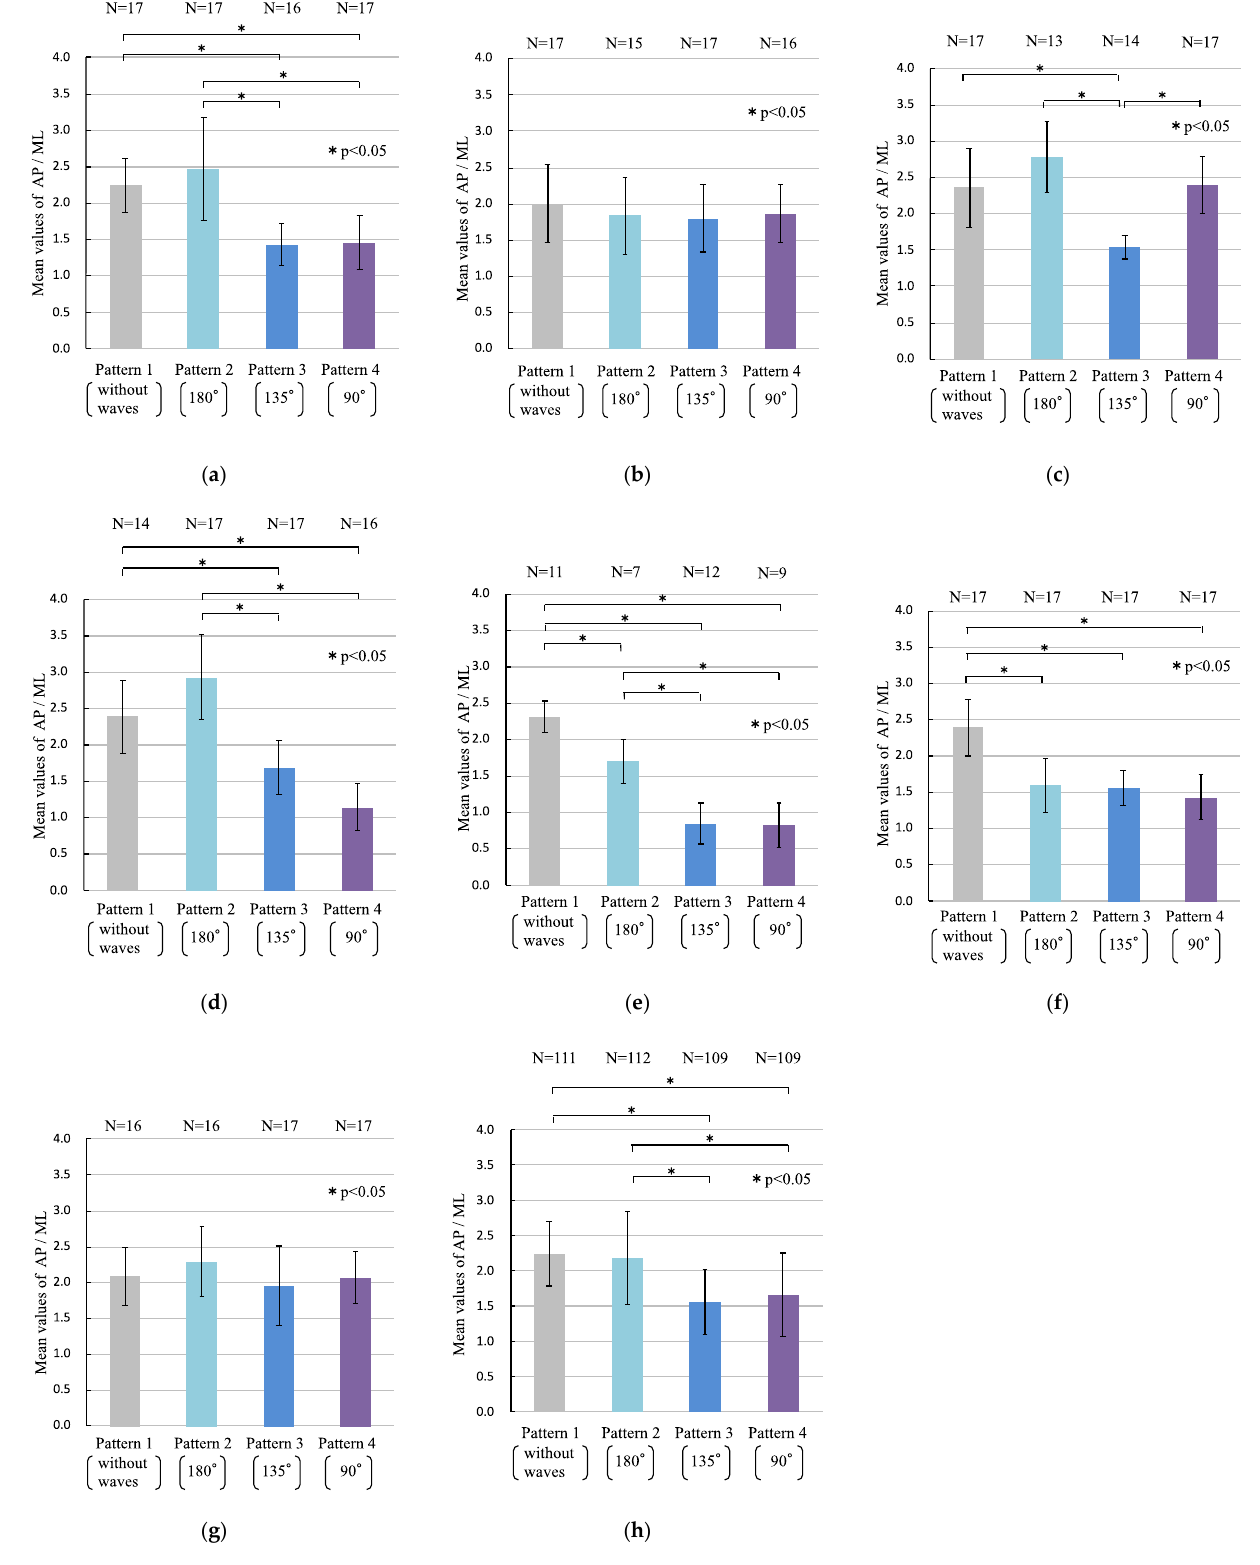
Figure 9. Ratio of the anteroposterior (AP) length to the mediolateral (ML) length of the center of pressure (COP) ( AP / ML ): ( a ) participant A; ( b ) participant B; ( c ) participant C; ( d ) participant D; ( e ) participant E; ( f ) participant F; ( g ) participant G; ( h ) all participants. N is the number of valid R . The asterisk (*) indicates a significant difference (* p < 0.05).